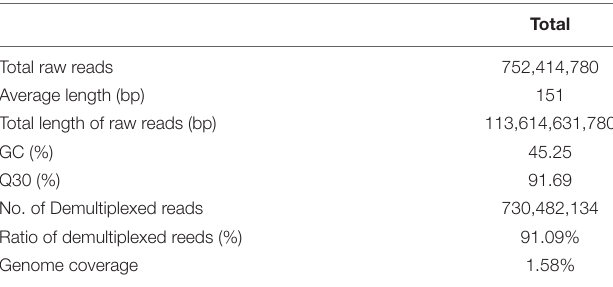
TABLE 1 | Summary of raw GBS sequence data.